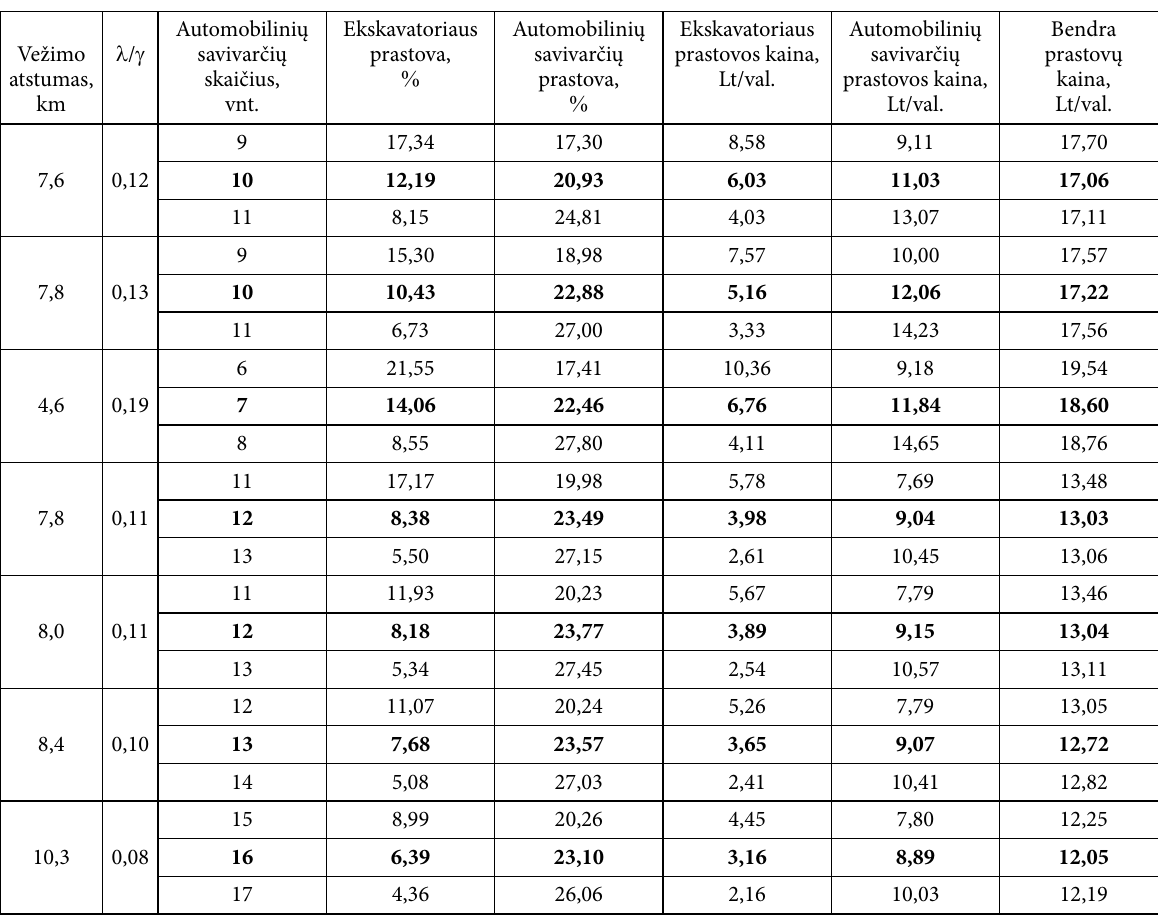
Table 5. Calculation of the idle time of an excavator and trucks Automobilinių Vežimo savivarčių atstumas, skaičius, km